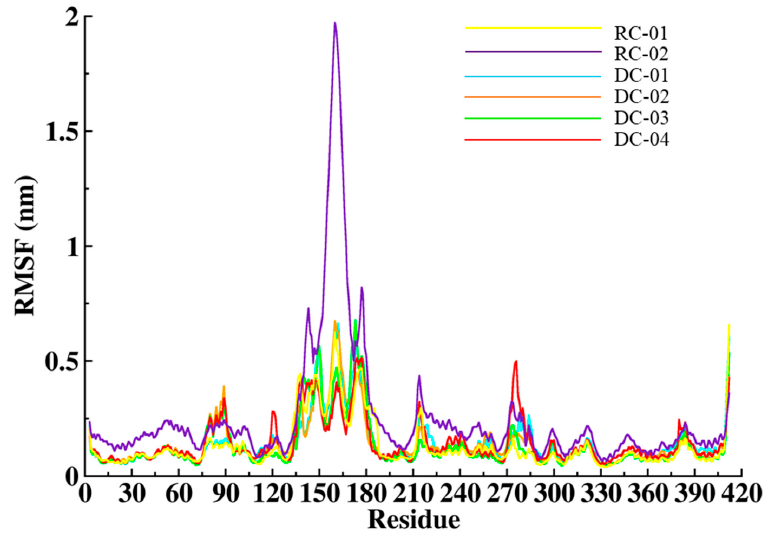
Figure 5. The overall RMSF analysis of designed and reference compounds.